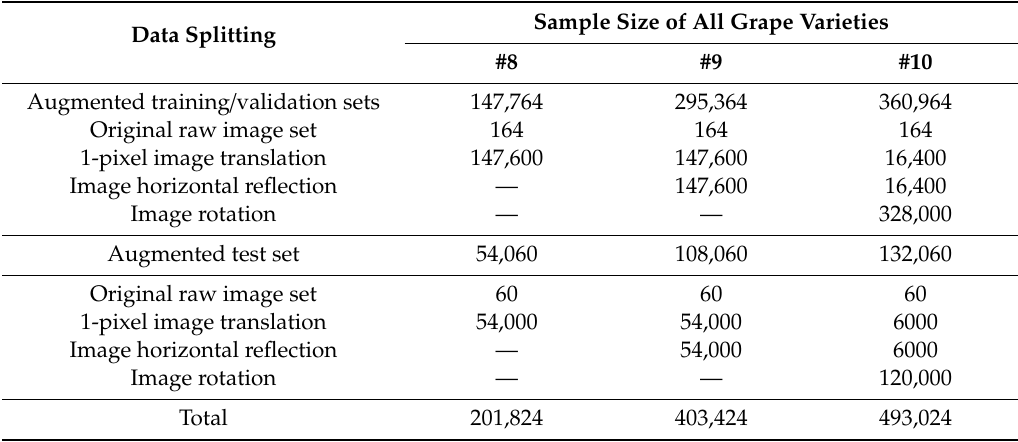
Table 3. Data splitting from DRGV + 2018 pre-processed datasets #8 to